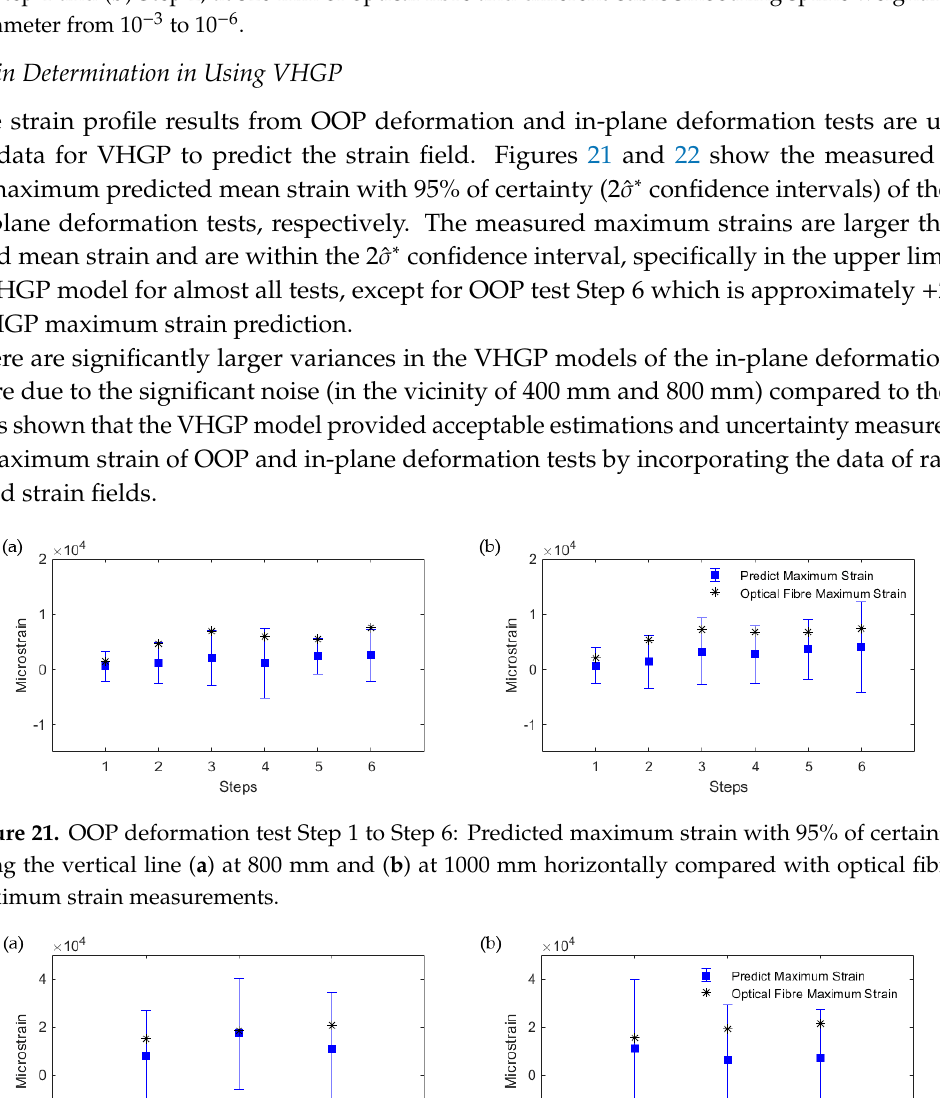
Figure 20. In-plane deformation test: Change in strain of Step 3 relative to the preceding strain; ( a ) Step 1 and ( b ) Step 2, at 320 mm of optical fibre and different cubic smoothing spline weighting parameter from 10 − 3 to 10 − 6 .